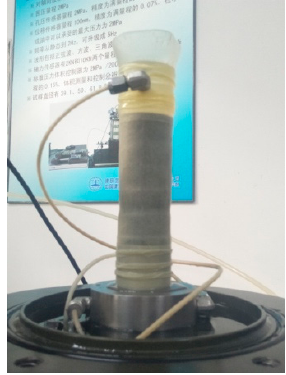
Figure 6. Example of a damaged sample.